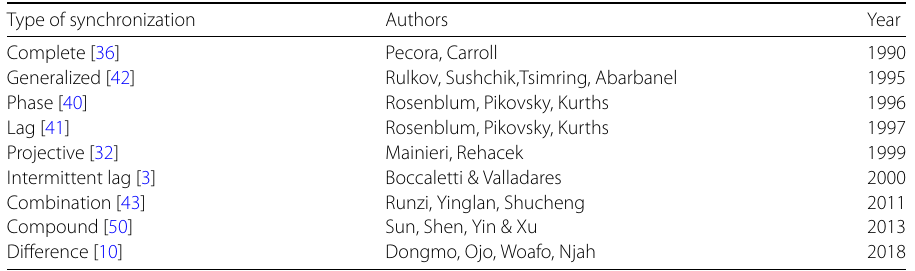
Table 1 Different Types of Synchronization Techniques Type of